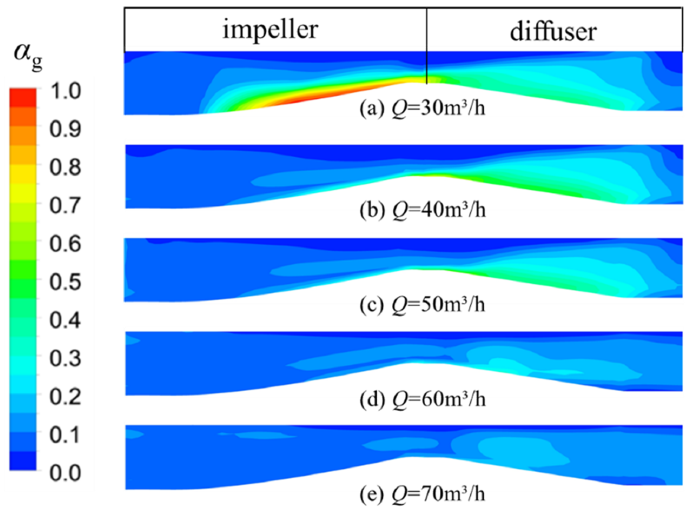
Figure 13. Distribution of gas void fraction in the impeller and diffuser under different flow rates ( Q = m 3 /h).